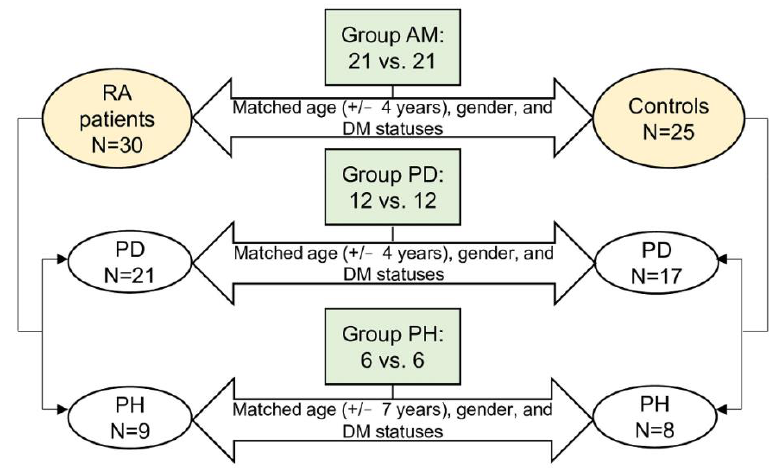
Figure 1. Study design and the flowchart. A total of 42, 24, and 12 participants were eligible for the final analysis in groups AM, PD, and PH, respectively. The RA and control participants were matched on age, gender, and DM statuses. Table 1. Clinical characteristics of the RA and control participants.